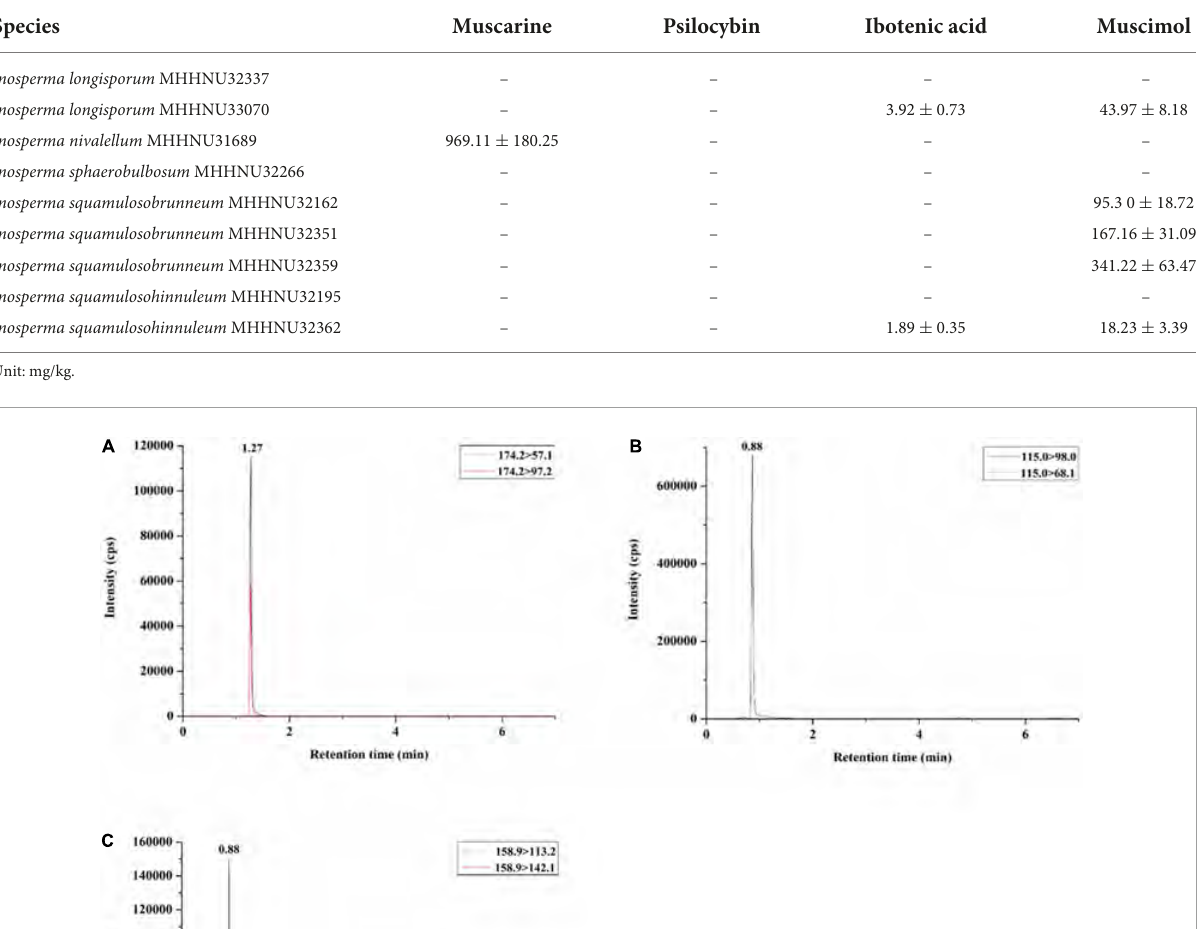
TABLE 2 Relative mushroom neurotoxins concentrations measured by UPLC-MS/MS.